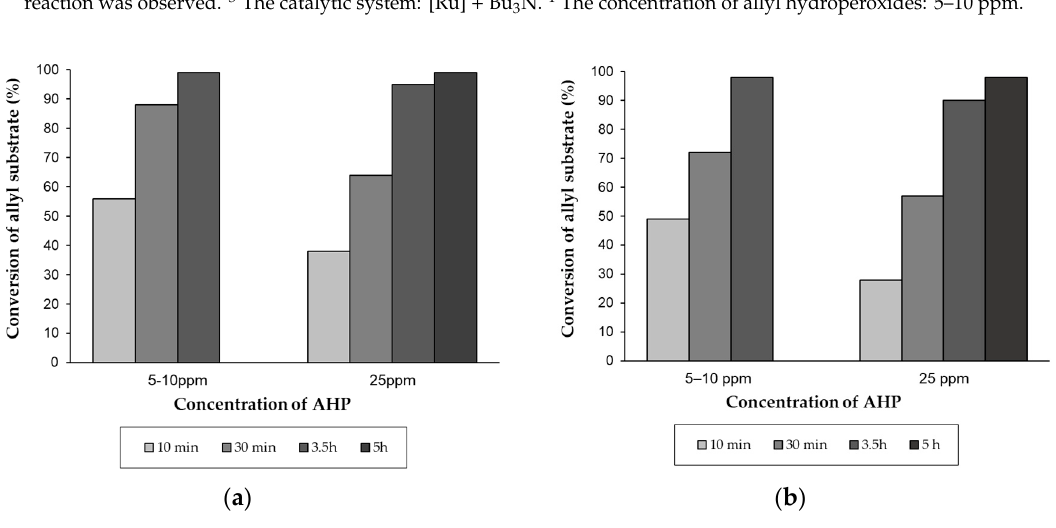
Figure 1. The effect of concentration of allyl hydroperoxides (AHP) from 4-allyloxybutan-1-ol on the catalytic activity ( a ) [RuClH(CO)(PPh 3 ) 3 ]+Bu 3 N or ( b ) [RuCl 2 (PPh 3 ) 3 ]+Bu 3 N in the isomerization to ( Z )- and ( E )-4-(1-propenyloxy)butan-1-ol (the reaction conditions: scale 50 mmol, 120 °C, [Ru] = 0.005 mol%, Bu 3 N/[Ru] molar ratio = 50, argon atmosphere, magnetic stirrer).